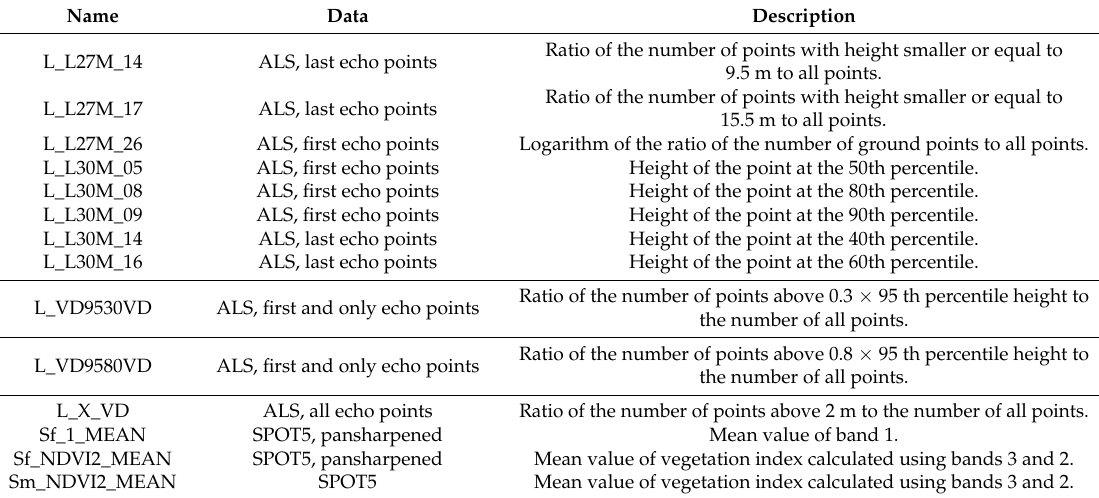
Table A1. Description of calculated Airborne Laser Scanning (ALS) and SPOT 5 ( Satellite Pour l’Observation de la Terre ) variables used in the inventory